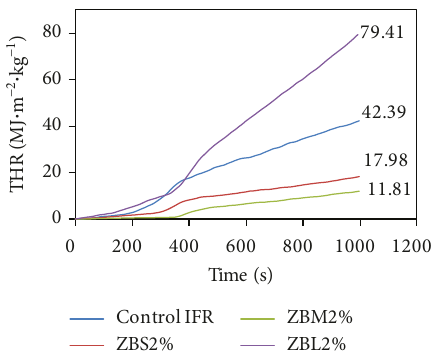
Figure 11: Total smoke production of wood treated with IFR/ZB coatings (50 kw · m -2 ).